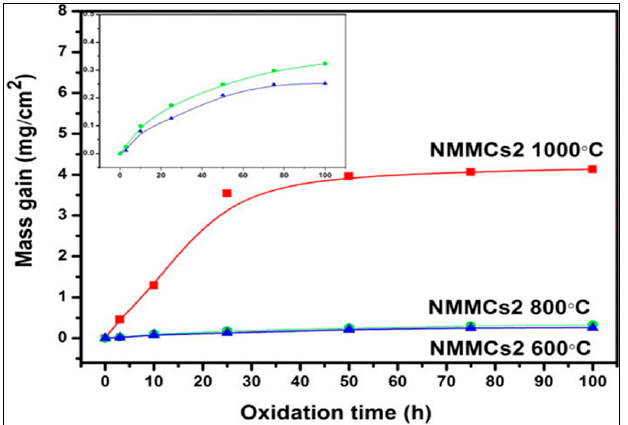
Figure 24. Isothermal-oxidation kinetics of LMD-processed Inconel 625, Inconel 625/2.5 wt.% TiC (NMMCs1), and Inconel 625/5.0 wt.% TiC (NMMCs2) parts (adapted with permission from Ref. [71] 2014, AIP Publishing).